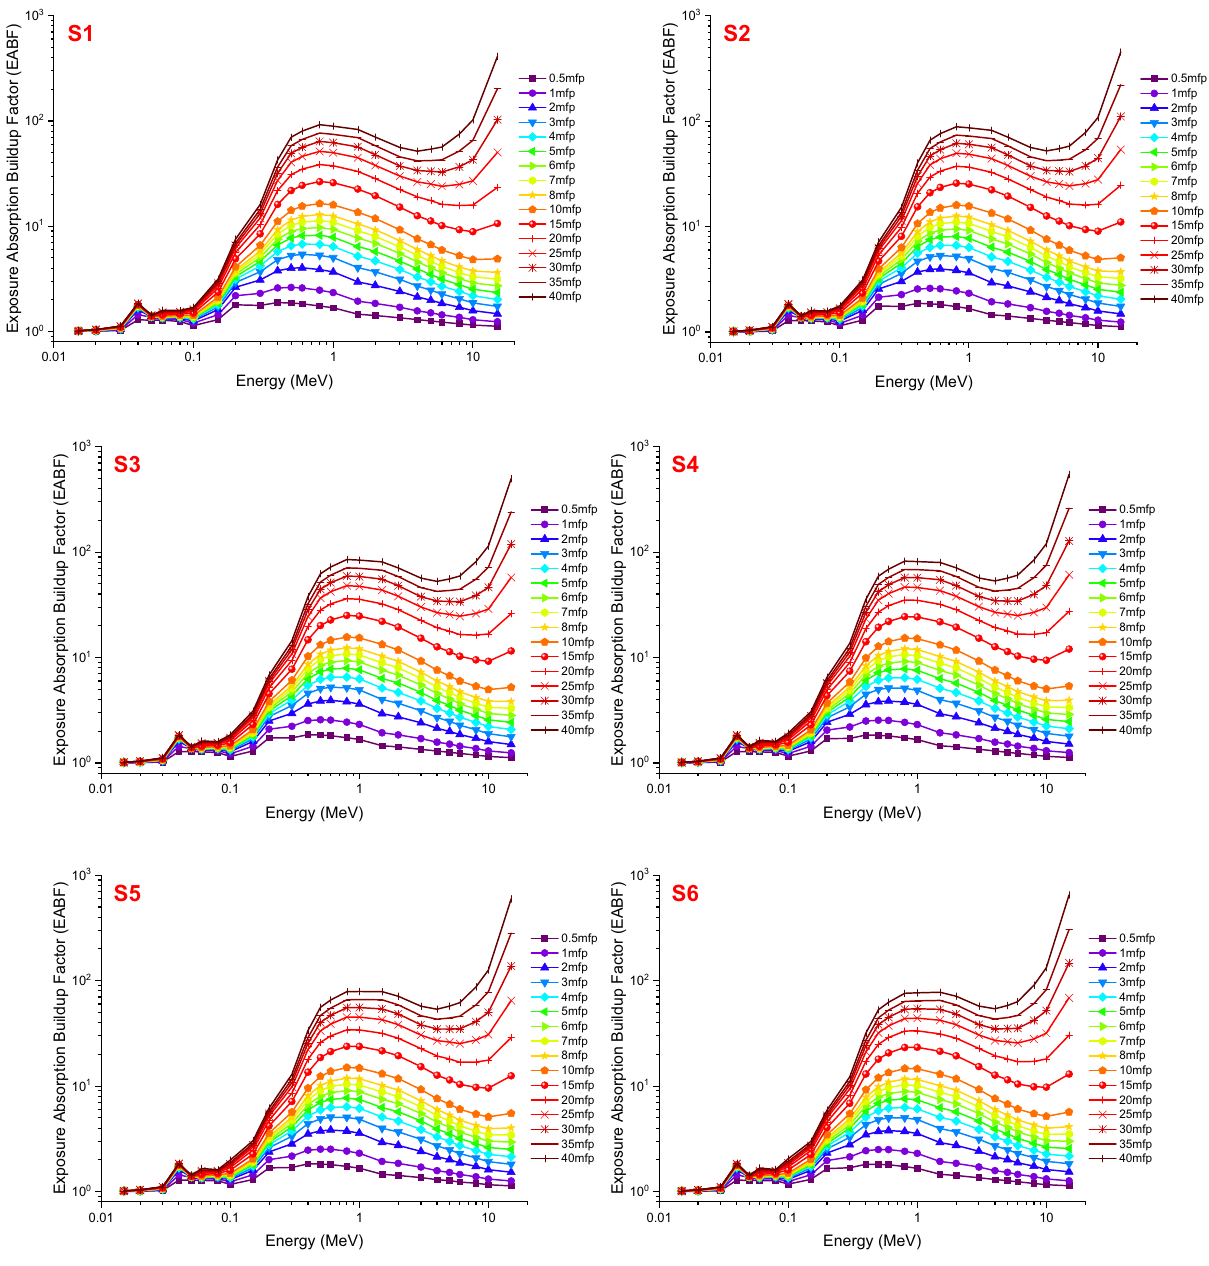
Figure 6: Variation of EABF of investigated glasses at di ff erent mean free path